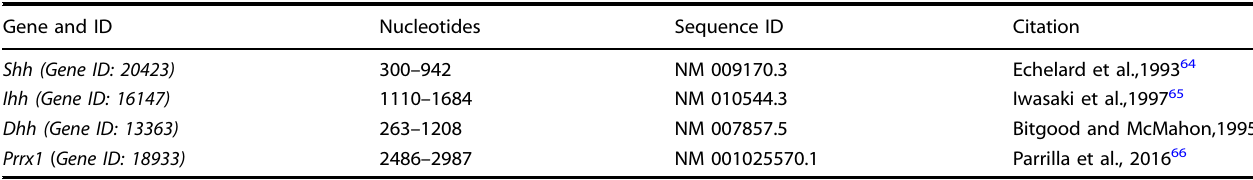
Table 3. Probes for RNA in situ